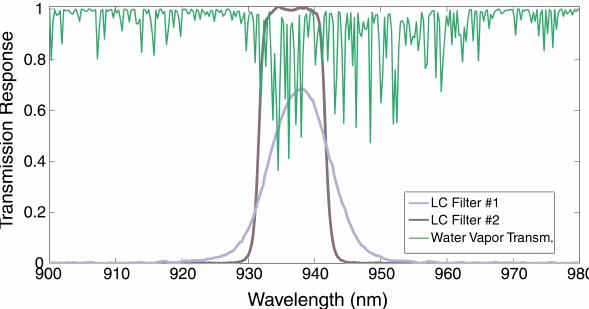
Fig. 1 : Filter transmission responses associated to both LC channels located within water vapor Fig. 1. Filter transmission responses associated with both LC chan- absorption band. MODTRAN Mid-latitude summer water vapor transmission is also included. nels located within water vapor absorption band. MODTRAN mid- latitude summer water vapor transmission is also